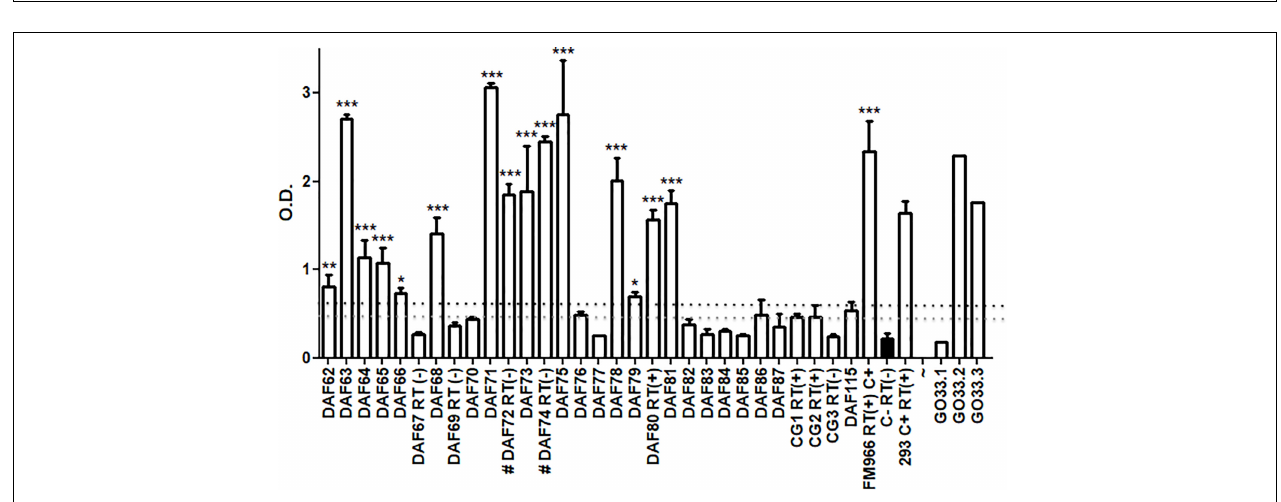
FIGURE 2 | ELISA assay for 30 independent Commelina plants (DAF62-87, DAF 115, and CG1-3) collected from field in two distinct localities of Brazil. Averages and SD of OD values from three technical replicates of each plant are showing. GO33.1-3 represents healthy cotton plants where virus was transmitted from aphids collected from Commelina positive and negative plants. The OD values of each plant were compared with 3 healthy cotton plants used as negative control (in black). Statistical analyses were performed using one-way ANOVA with the Bonferroni test with p < 0.5. The black dashed line shows a value corresponding to 3 times the average of negative control and the gray dashed line shows 2.5 times values. These dashed lines are representing the ELISA cut-off. RT – plants assayed by RT-PCR. C+ - FM966 and 293 CLRDV infected plants. * p < 0.05, ** p < 0.01, and *** p < 0.001.